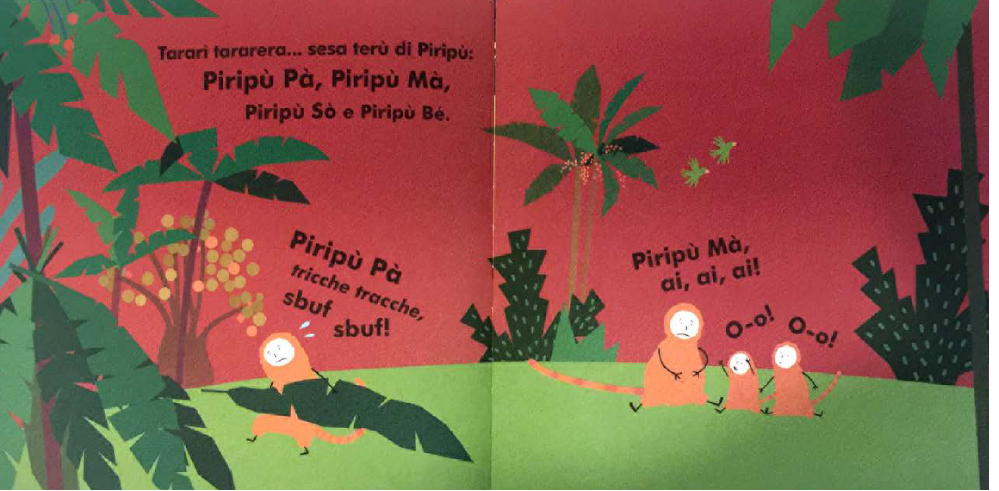
93 www.img-network.it